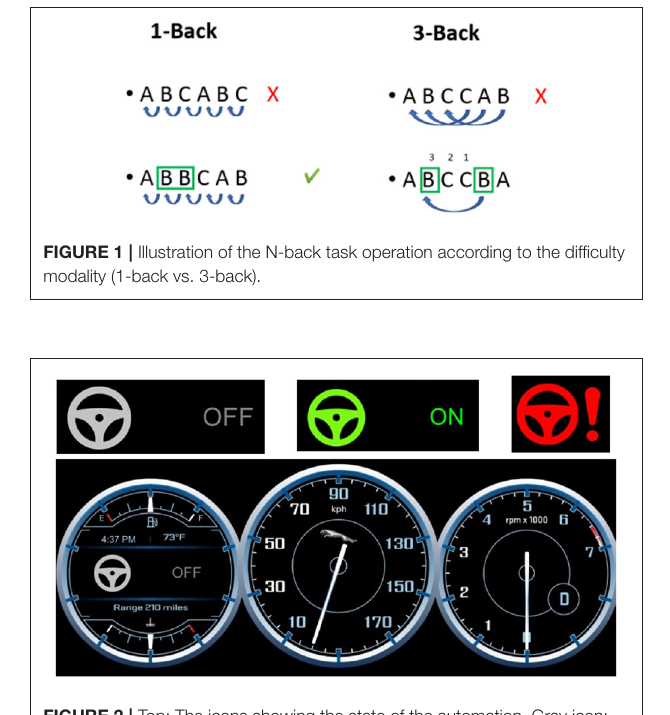
tablet (application vs. no application). Also, participants